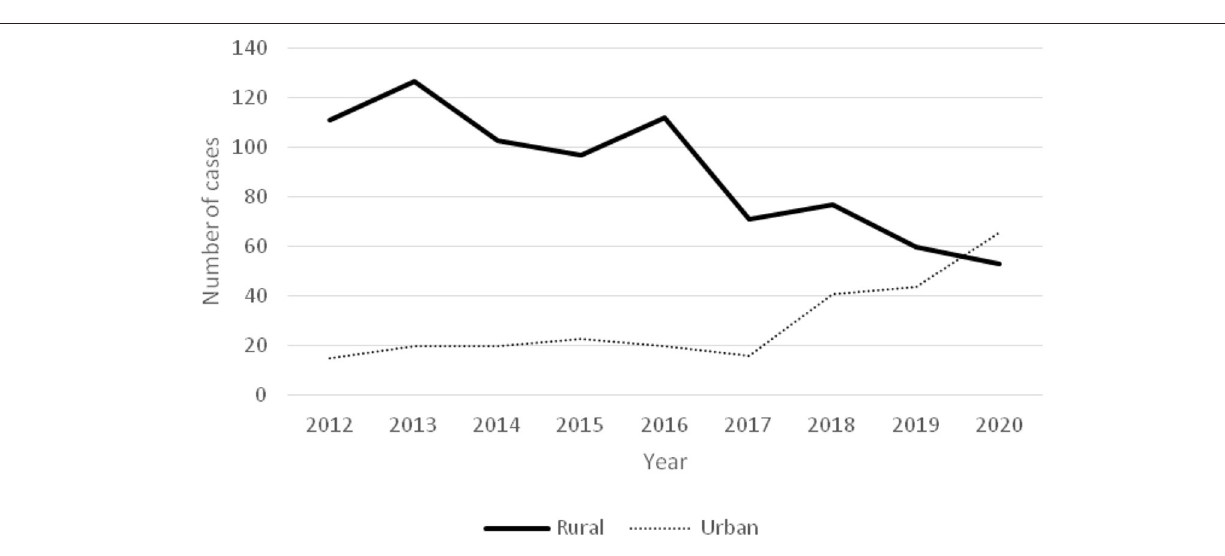
FIGURE 2 | Time-varying curve of the number of poisoning in children in rural and urban